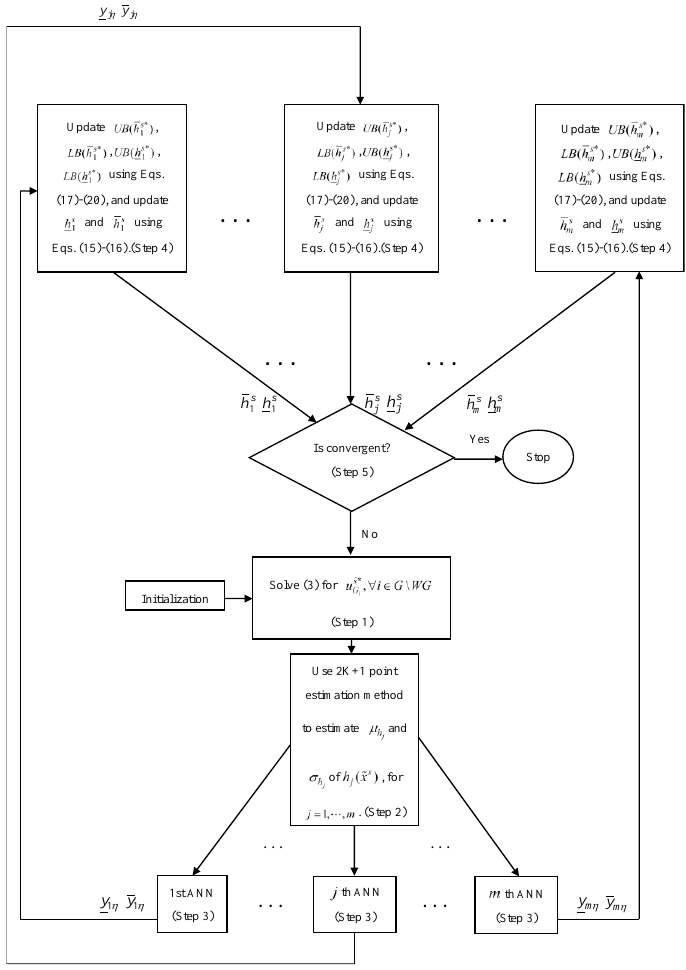
Figure 2. Flow chart of the risk-limiting schedule of optimal non-renewable power-generation algorithm.